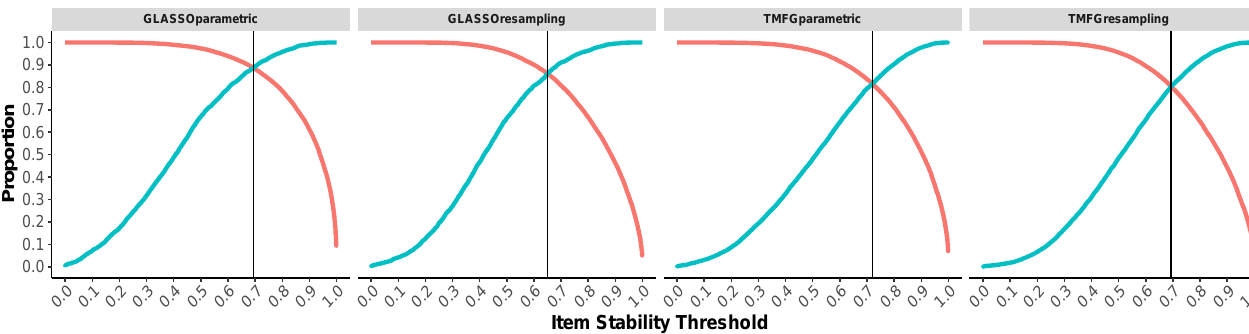
Figure 3. Item stability threshold by correct and incorrect placements of